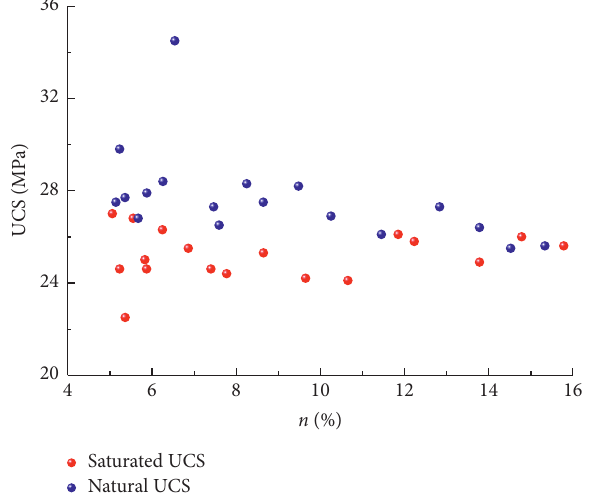
Figure 5: The relationship between the UCS and the porosity ( n � 5% ∼